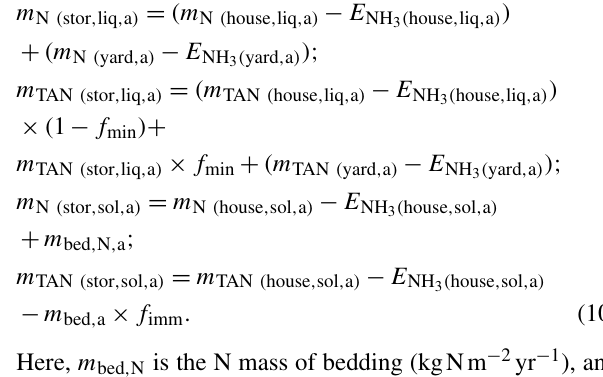
Table 2. Default values for the fractions of the year spent grazing and in the yard, the proportion of TAN in the N mass retained, and the straw used as bedding. The information has been taken and adapted from EMEP/EEA (2019). The straw used as bedding for pigs is the average between different livestock types. The N retained is taken from Paustian et al. (2006). x graz x yard N retained x TAN Straw (–) (–) (–) (%) (kghead − 1 yr − 1 ) Dairy cattle 0.5 0.25 0.20 60 1500 Non-dairy cattle 0.5 0.10 0.07 Pigs Chickens 0 Small ruminants